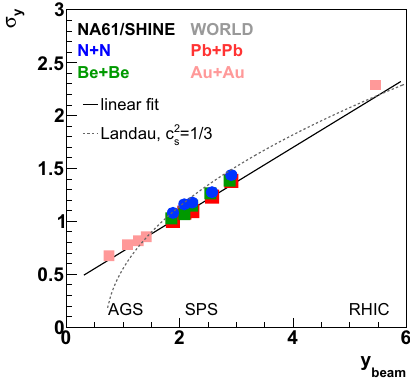
Fig. 19 Comparison of the Landau hydrodynamical model with rapid- ity distributions of charged pions produced in central nucleus–nucleus collisions and inelastic nucleon–nucleon interactions. Left: The width σ y of the rapidity distributions of negatively charged pions in central Be + Be, Pb + Pb [2,3] (Au + Au [32,33]) reactions and the width σ y of the average of rapidity distributions of positively and negatively